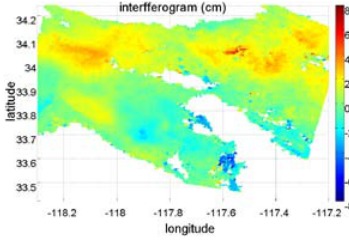
Figure7. Original interferogram